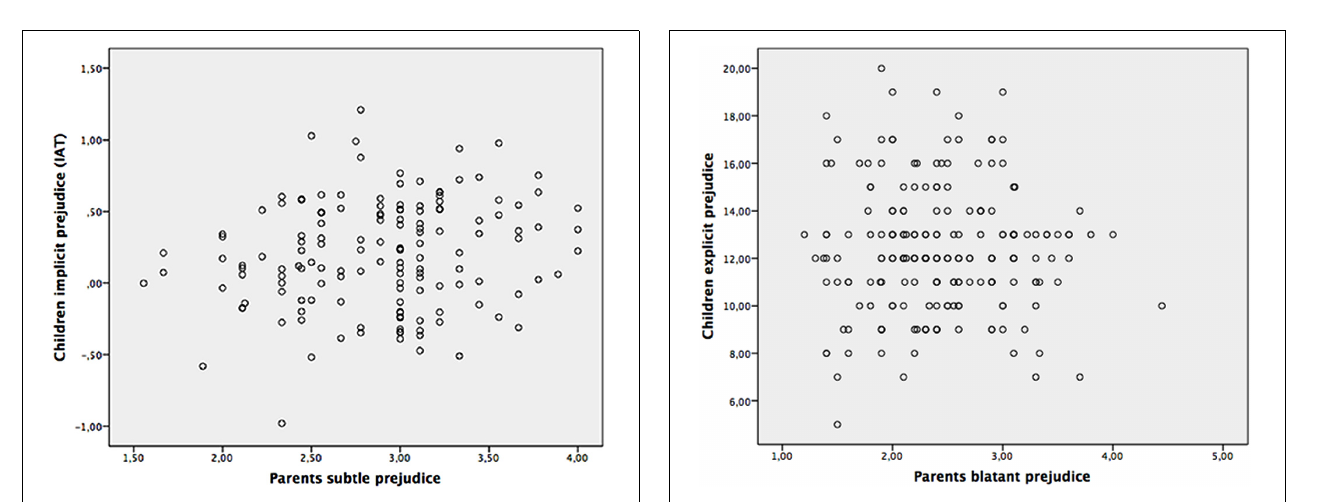
ethnic prejudice across age ( F ( 2 , 341 ) = 4.13, p = 0.017). The ethnic explicit prejudice significantly increases from preschool